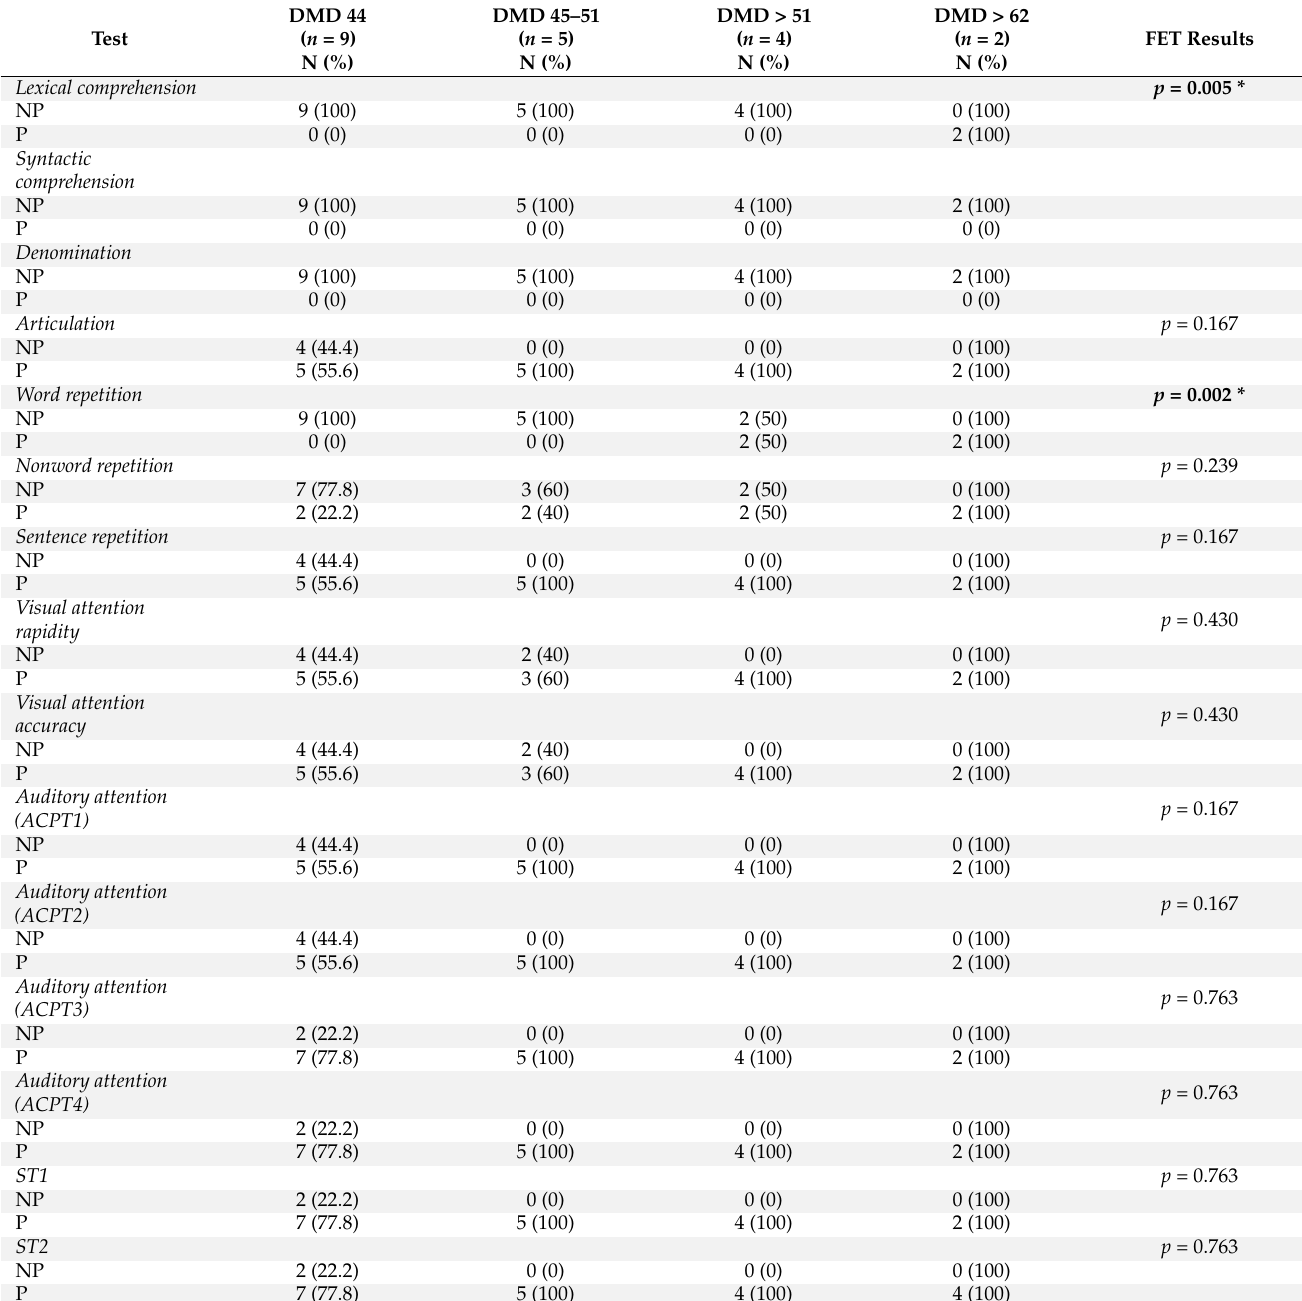
Table 2. Comparison within Duchenne muscular dystrophy (DMD) group regarding administered